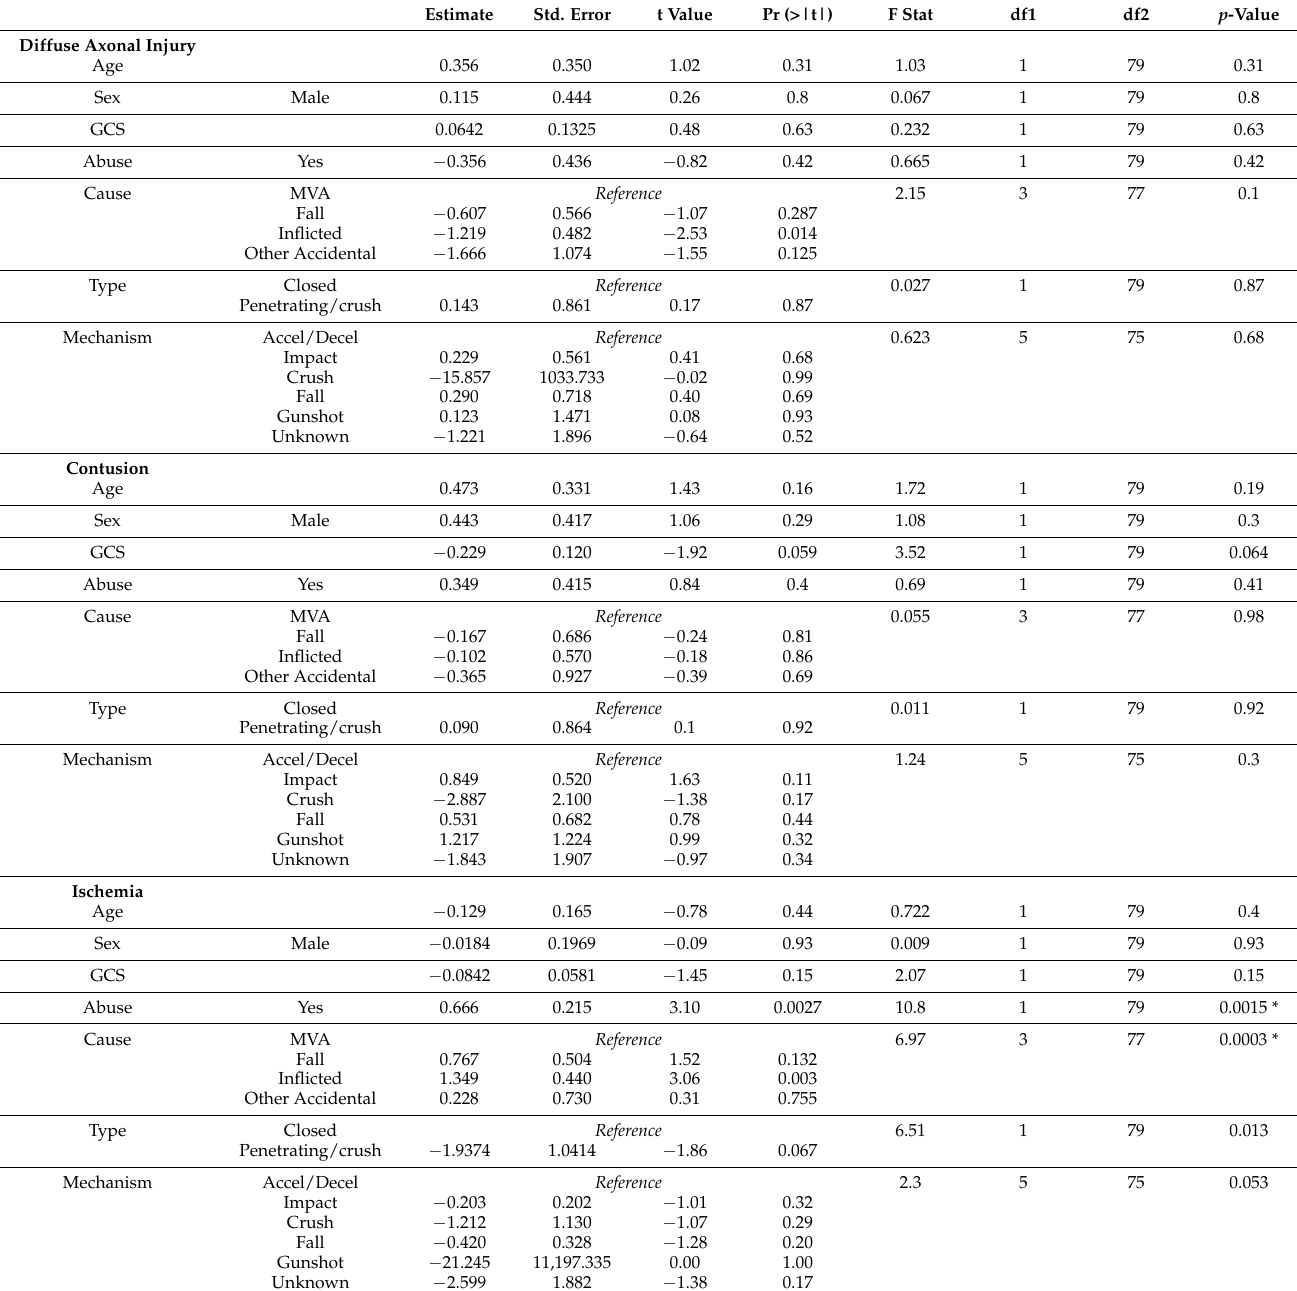
Table 3. Linear Density Ratio univariate models of lesion type with injury